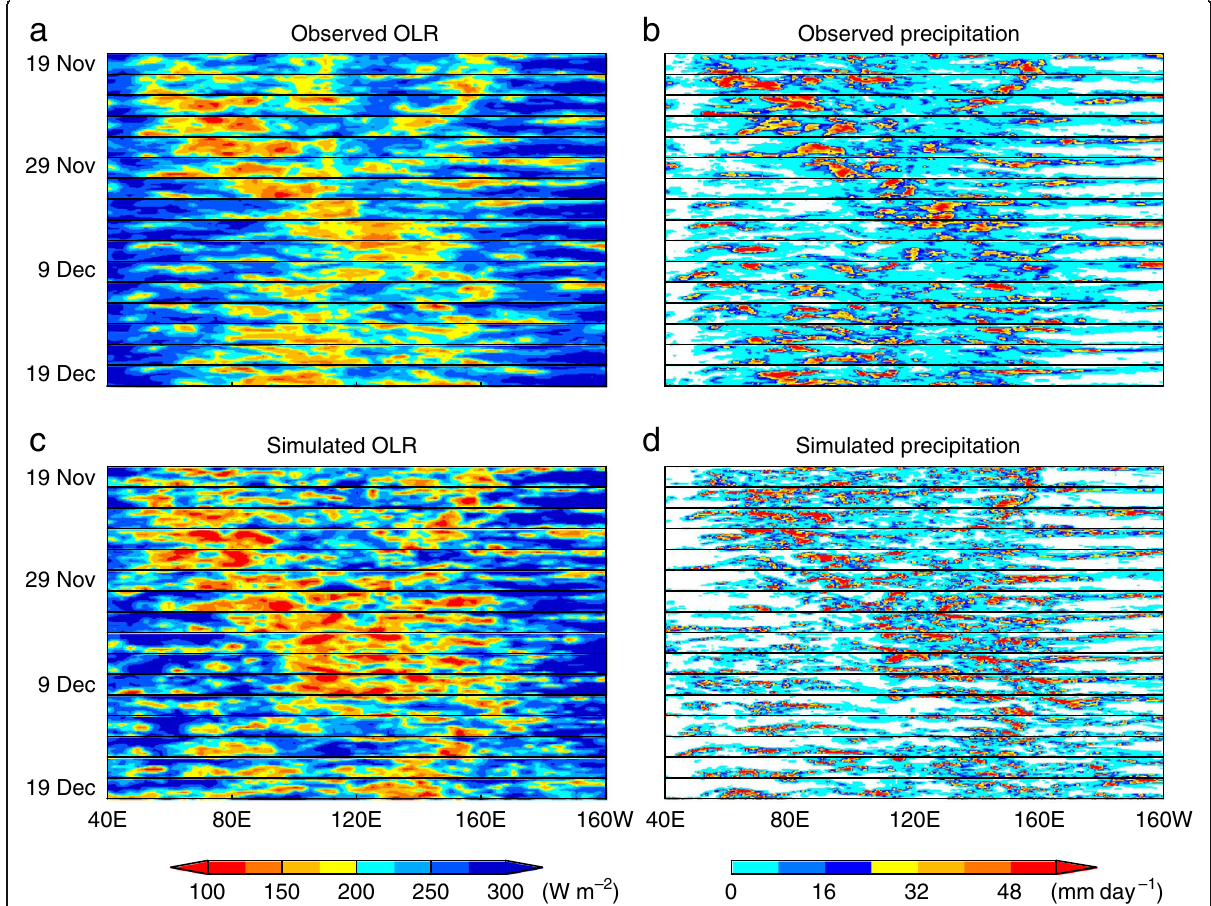
Fig. 8 Precipitation anomaly composites for different Madden-Julian oscillation (MJO) phases. a Interpolated OLR by NOAA polar-orbiting series of satellites (NOAA-OLR; Liebmann and Smith, 1996) and c OLR by a single simulation initialized at 00 UTC 17 November 2011. b Precipitation by the 3B42 product of the Tropical Rainfall Measuring Mission (TRMM) satellite (Huffman et al. 2007) and d precipitation by the simulation. The figures consist of slices that show horizontal snapshots of the tropical Indian Ocean to the western Pacific Ocean (10°S – 10°N, 40°E – 160°W). The resolution of the simulated OLR is lowered to 2.5° mesh to equal the resolution of the NOAA-OLR data set. The resolutions of the TRMM 3B42 data set and the simulated precipitation are lowered to 1° mesh. After Fig. 3 of Miyakawa et al.